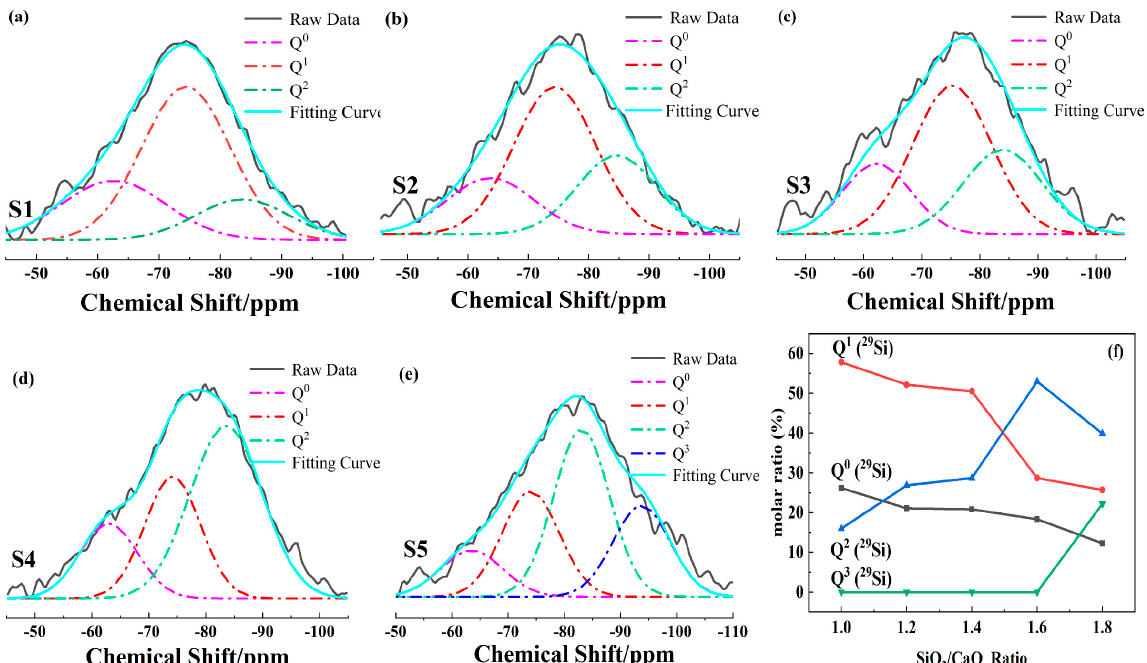
Figure 4. ( a – e ) Typical deconvolution of 29 Si NMR spectra for S1–S5. ( f ) Relative peak-area ratio of different Qn changes with the SiO 2 /CaO ratio.